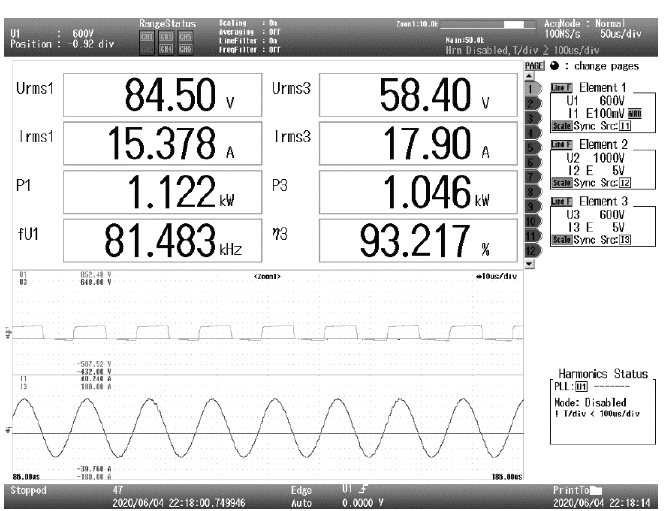
Figure 11. Experimental platform for coil positioning.